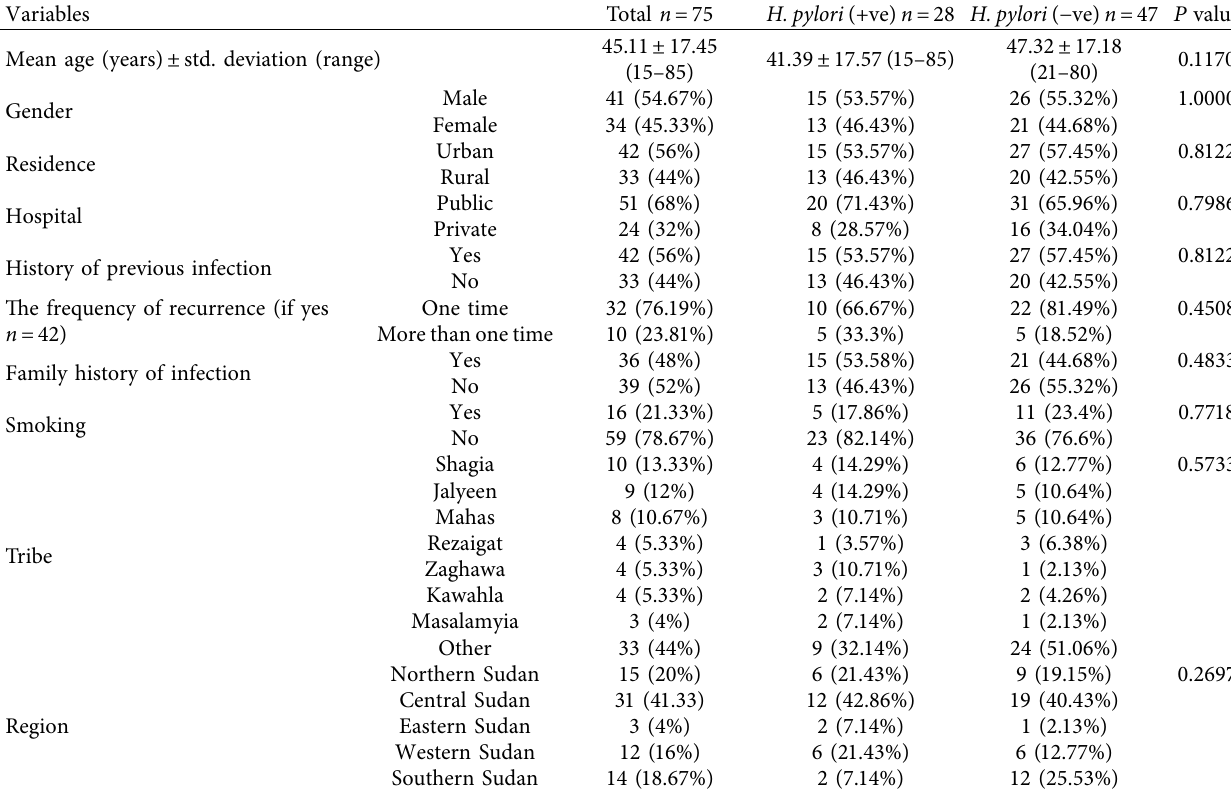
Table 1: Sociodemographic characteristic of